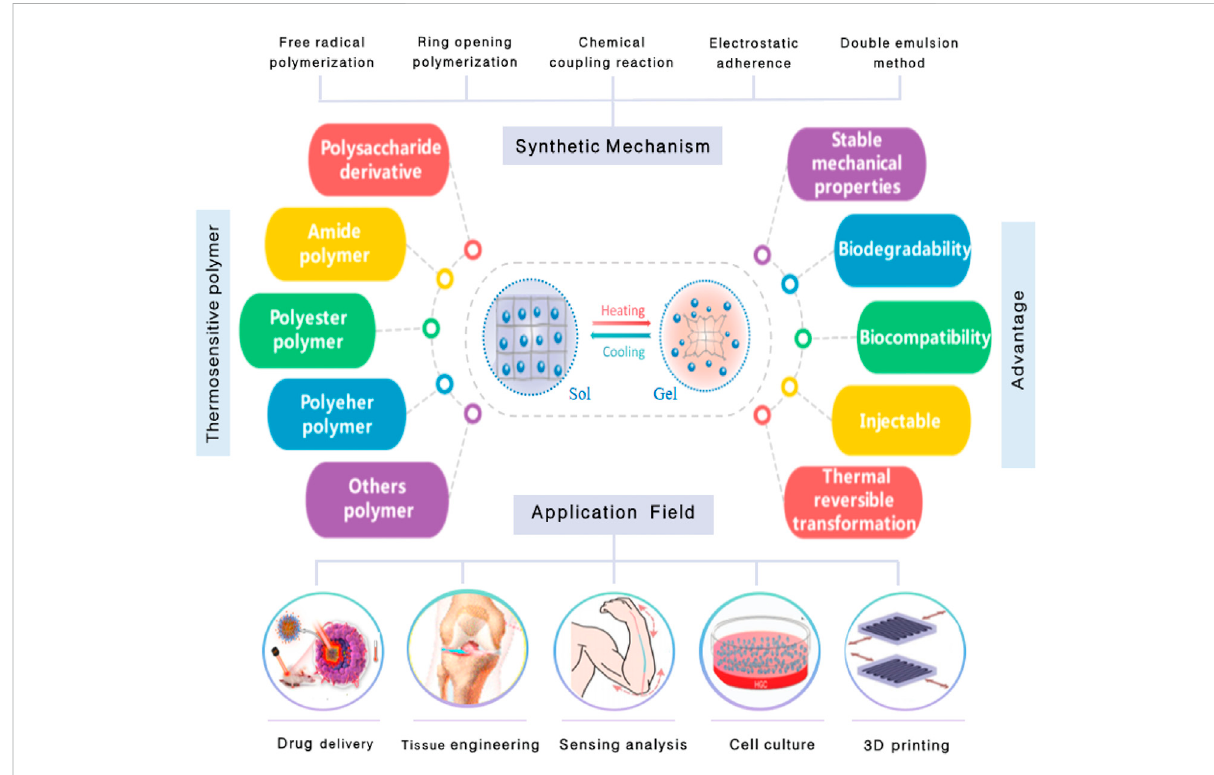
FIGURE 1 Synthetic mechanism, types, properties of thermosensitive nanomaterials, and their applications in the biomedicine fi